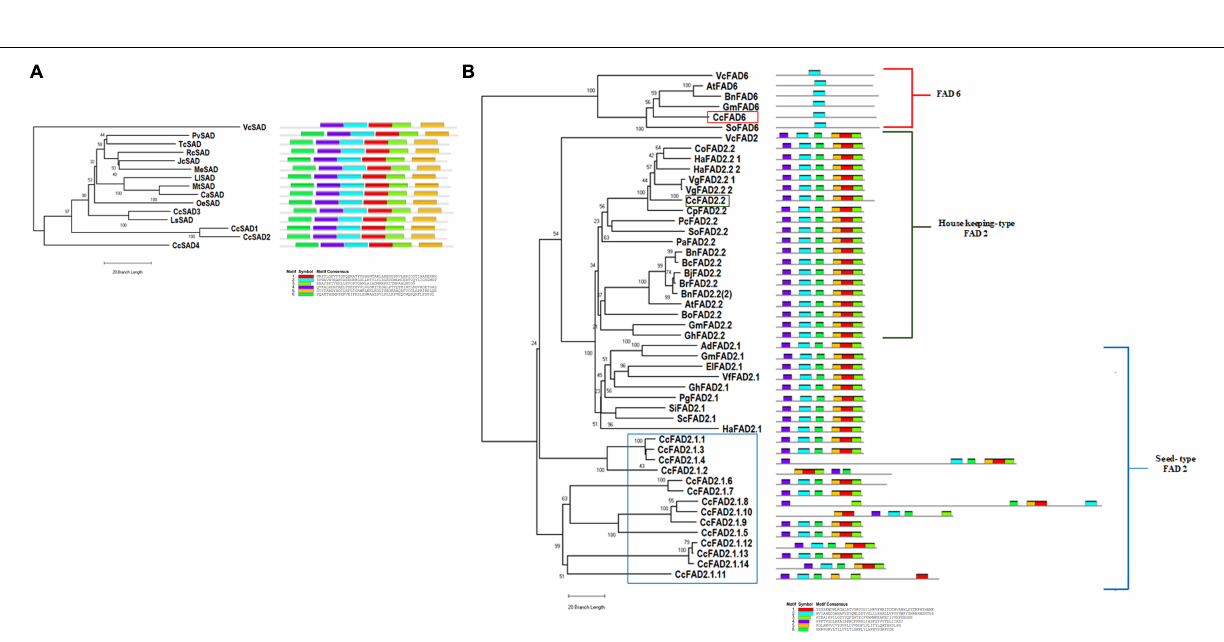
Frontiers in Plant Science |